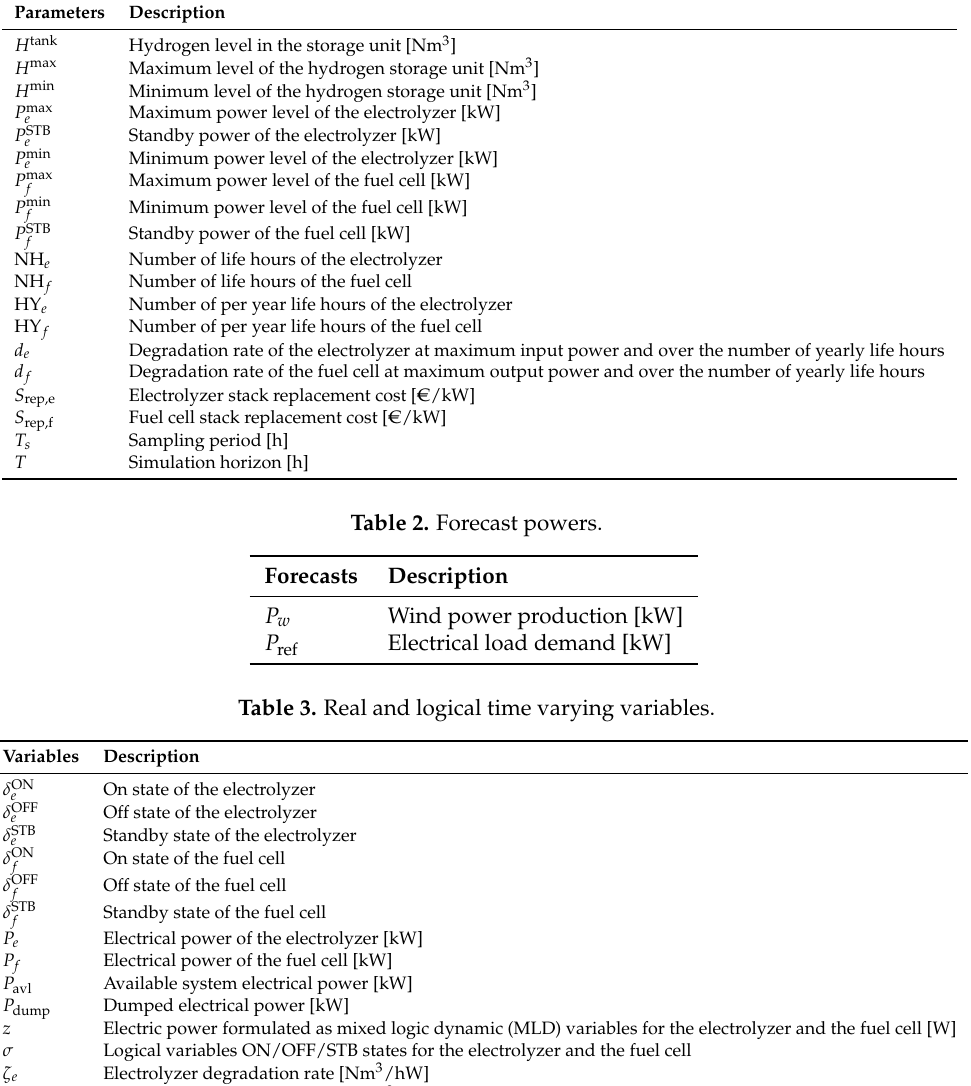
Table 1. Parameters.